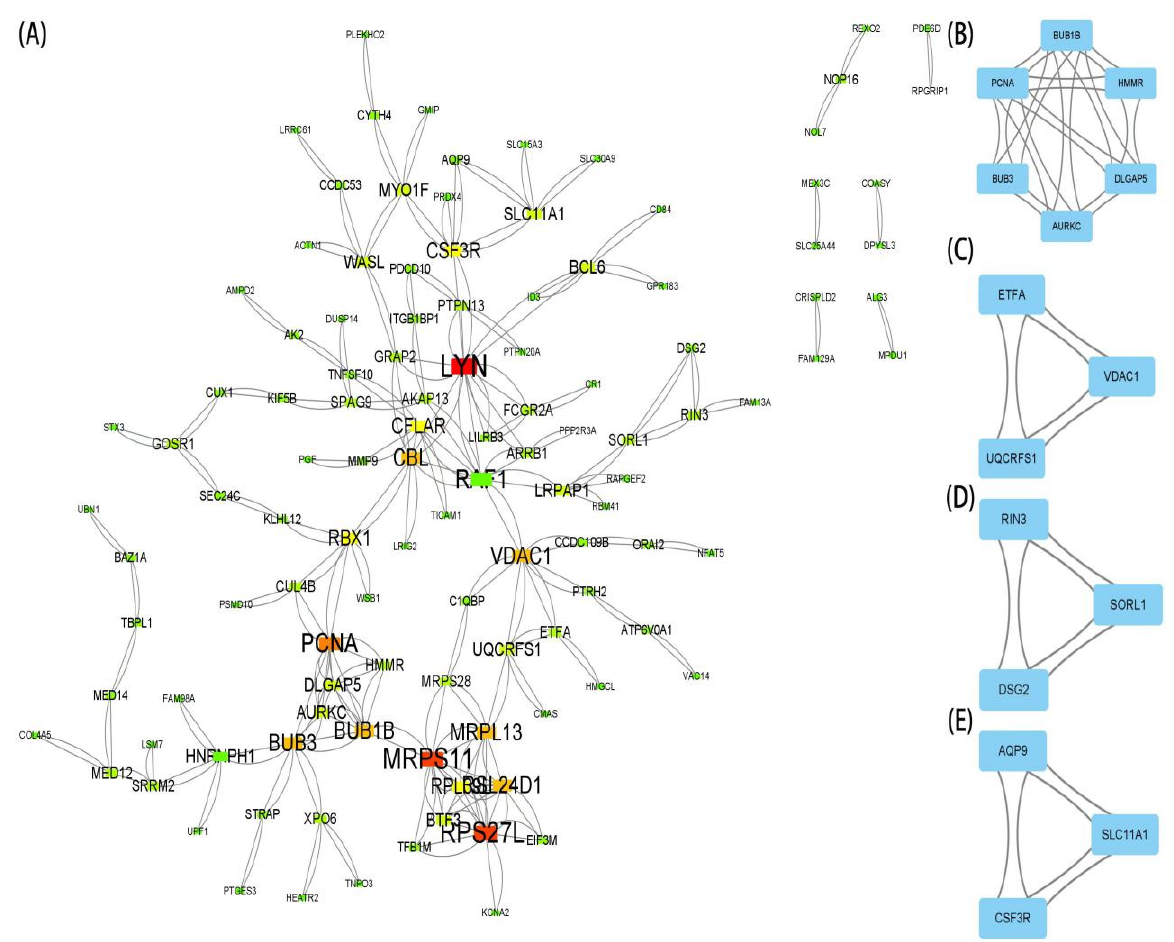
Figure 4. PPI network and significant gene module. ( A ) PPI network diagram. ( B – E ) The significant gene clustering modules.